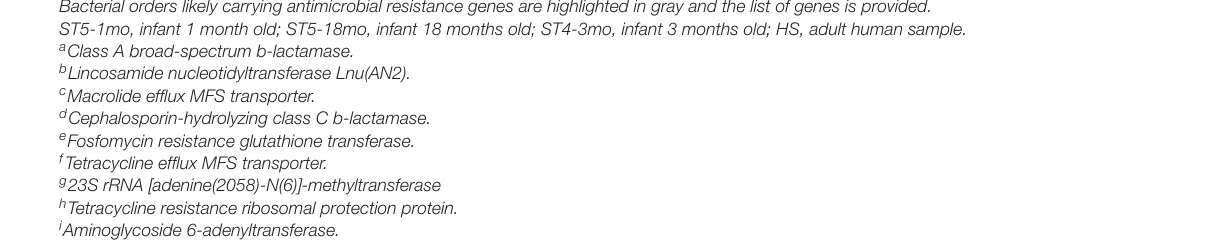
Tenericutes Acholeplasmatales Verrucomicrobia Verrucomicrobiales